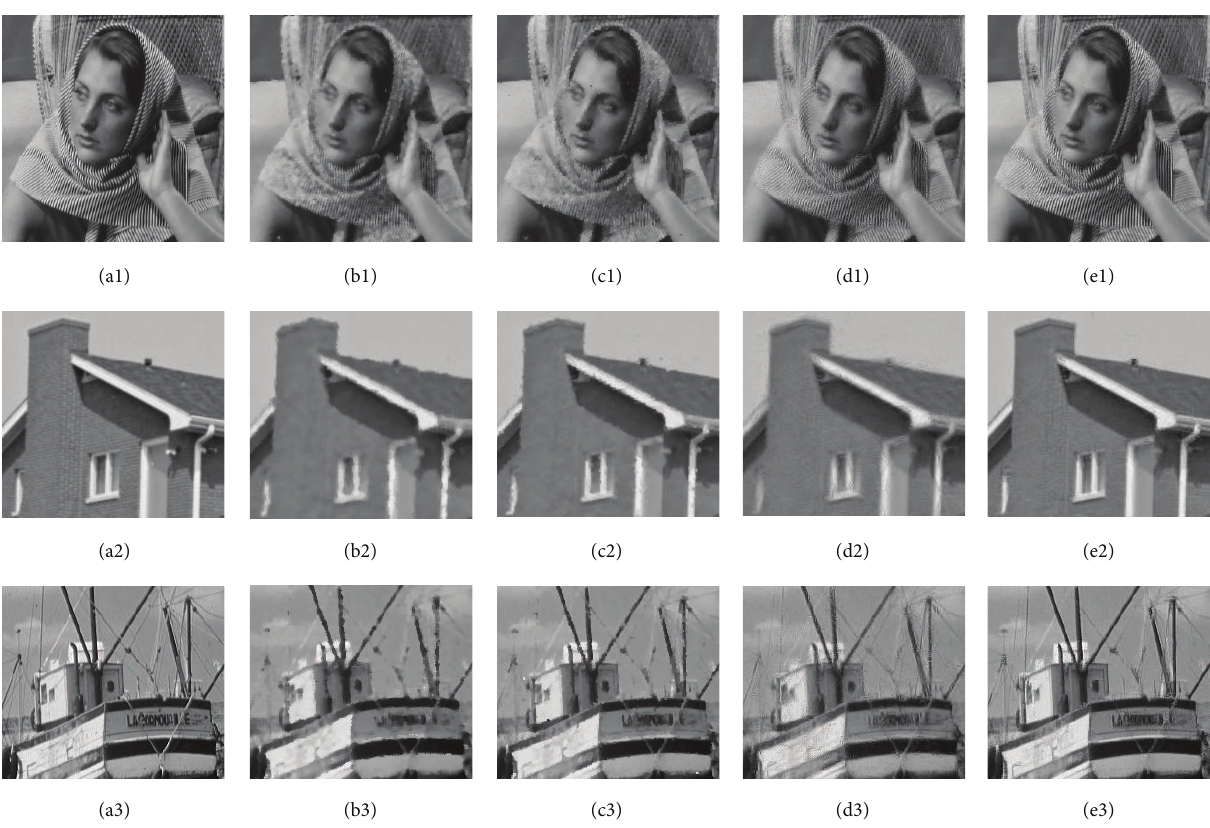
Figure 8: Denoised images with 30% random-valued impulse noise. (a1), (a2), and (a3) are original images; (b1), (b2), and (b3) are results of median filtering; (c1), (c2), and (c3) are results of total variation denoising; (d1), (d2), and (d3) results of the wavelet-based sparse representation denoising; (e1), (e2), and (e3) are results of the proposed